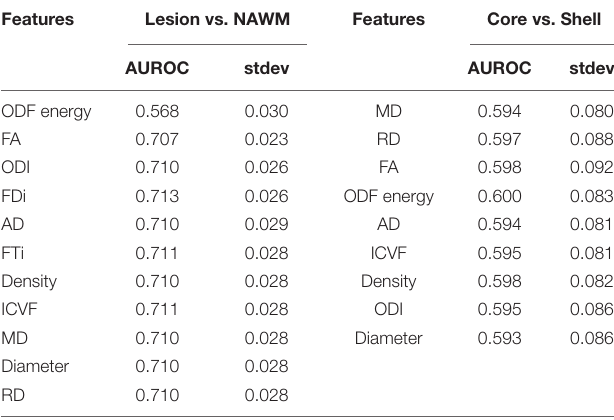
TABLE 3 | The AUROC outcome of the linear SVM classification models. Features Lesion vs. NAWM